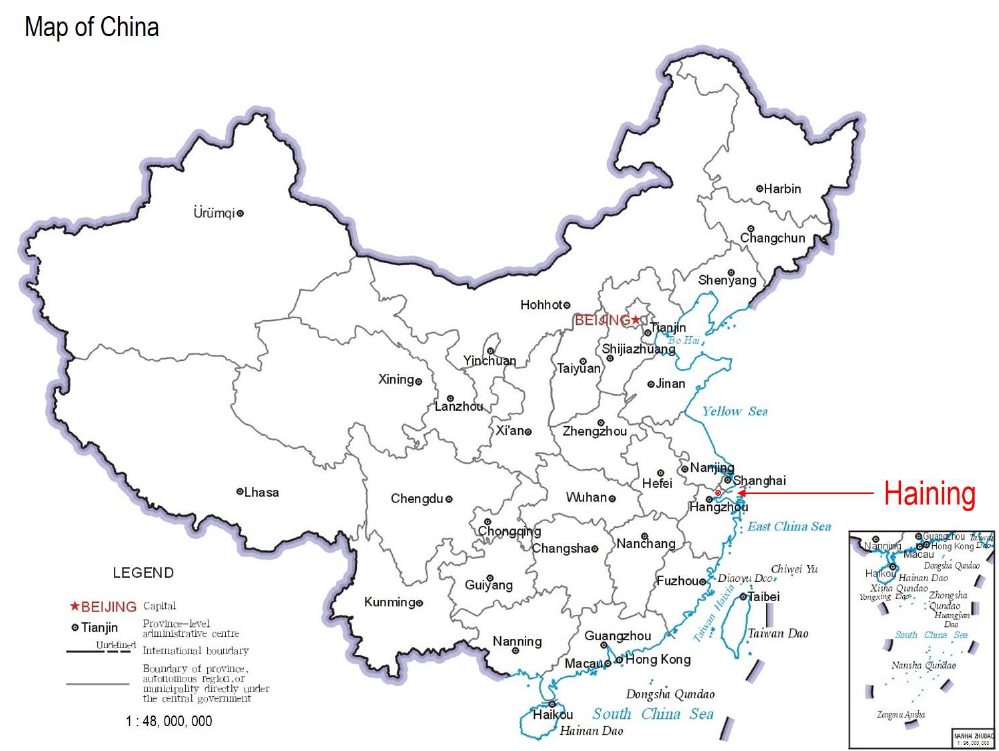
Figure 1. The location of City H in China. The base map is supervised and produced by the Ministry of Natural Resources of the People’s Republic of China, and the review number is GS(2019)1673. City H has a well-developed transportation network with a length of 1694.0 km, in- cluding 7.5 km of national roads, 59.7 km of provincial roads and 328.5 km of county